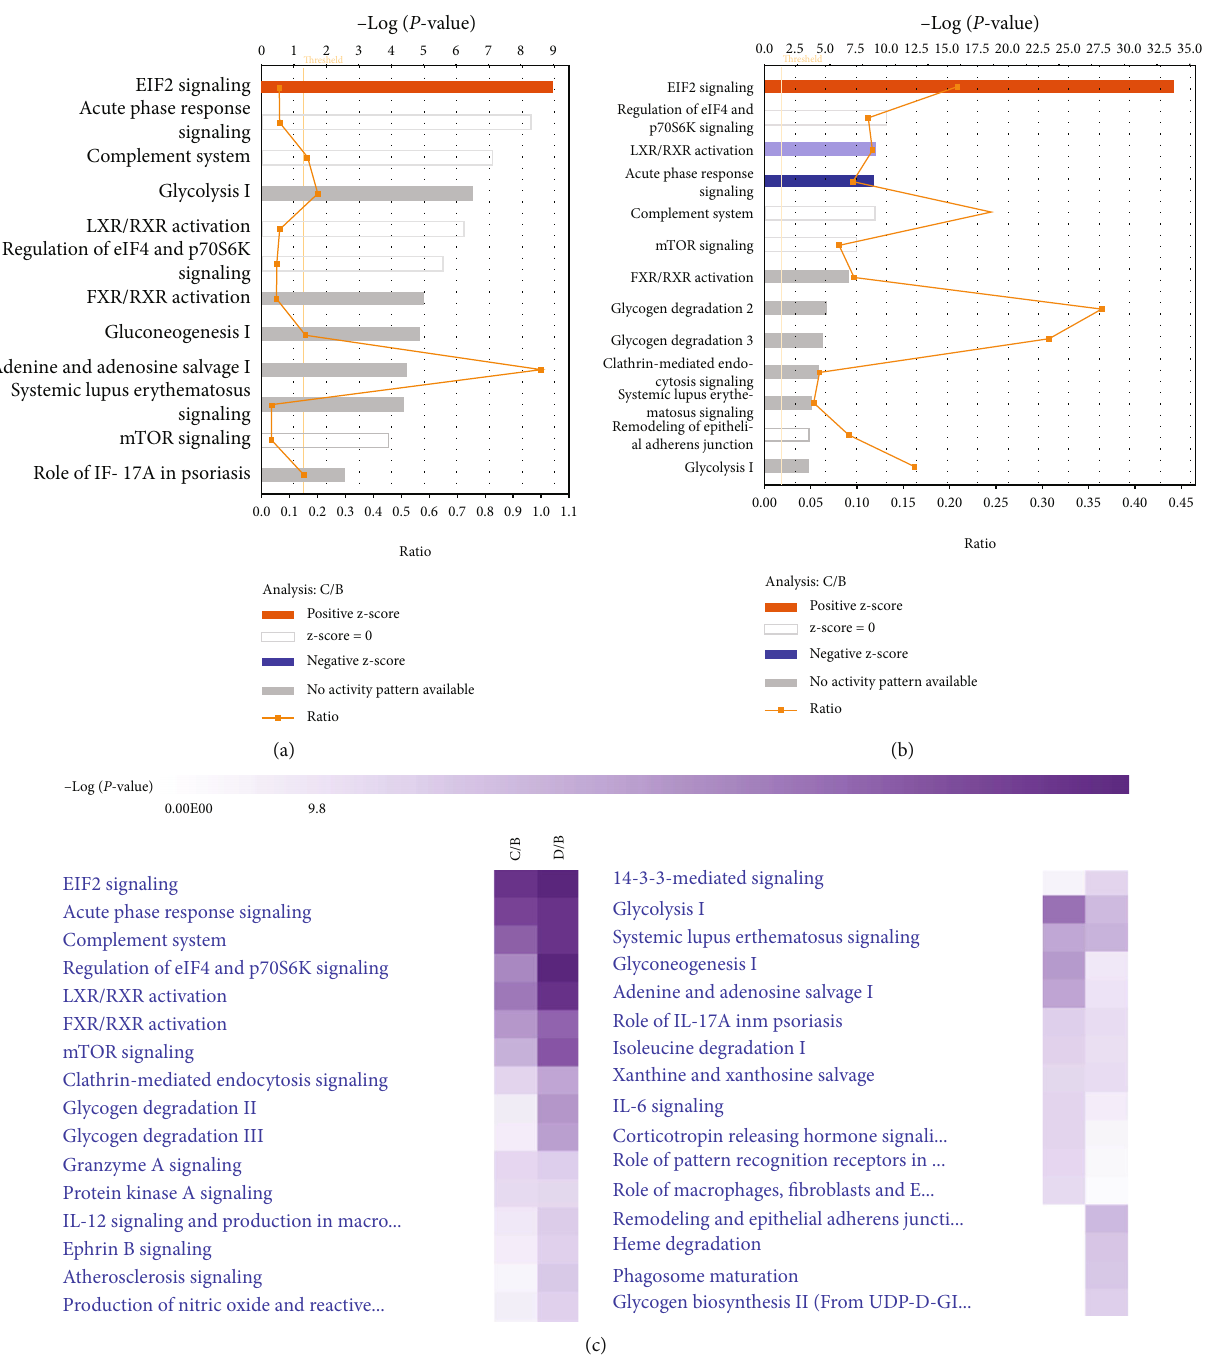
Figure 6: Statistics of signal pathways involved in di ff erential proteins in exudates at di ff erent stages. (a) The signaling pathway analysis of di ff erential proteins in C group (middle exudate) compared with that in B group (early exudate). (b) The signaling pathway analysis of di ff erential proteins in D group (late exudate) compared with that in B group (early exudate). (c) Trend analysis of intergroup signaling